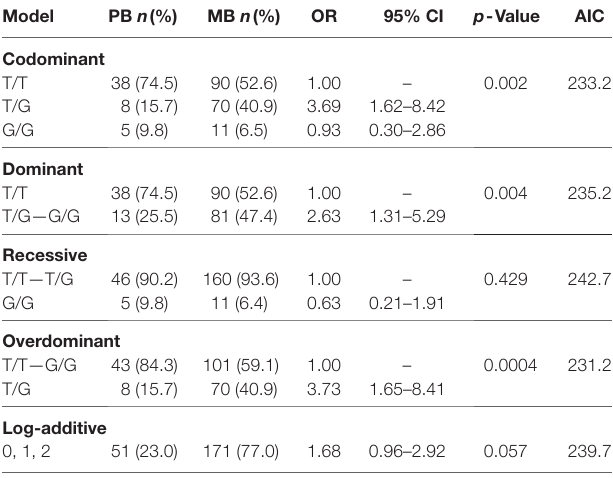
TaBle 4 | Different genetic models of association of TLR1 SNP with clinical forms of TB.